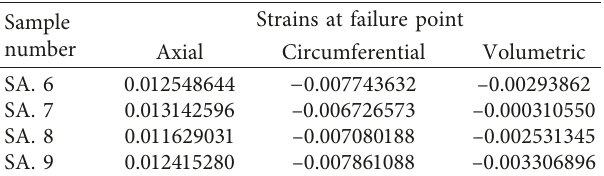
Table 3: Strain at the sample failure point in the cyclic loading